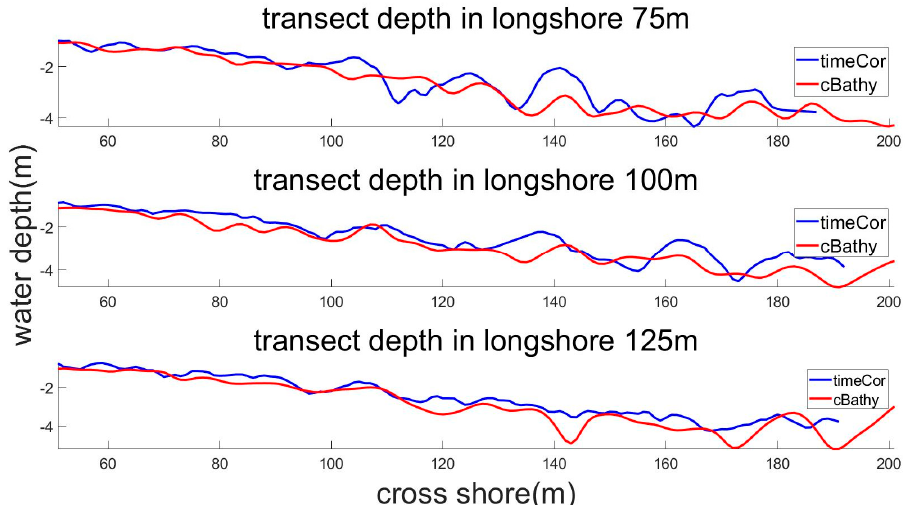
Figure 19. Comparison between timeCor and cBathy in longshore 75 m, 100 m, 125 m.